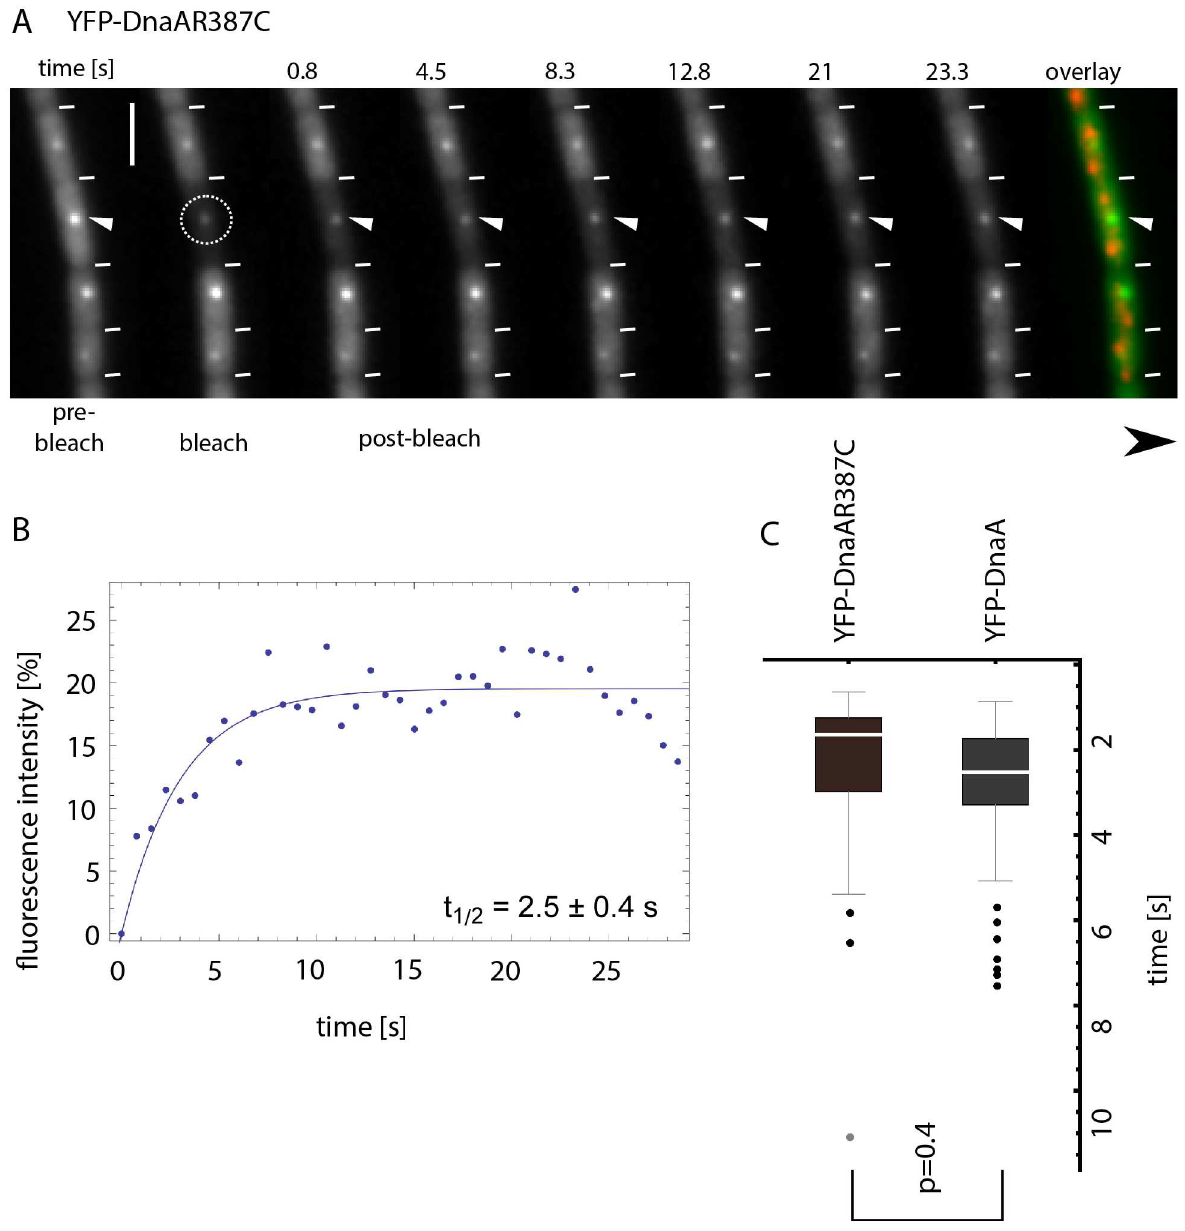
Fig 4. FRAP measurements of YFP-DnaAR387C. A) FRAP sequenceshowingthe recovery of YFP-DnaAR387Cfluorescence signal after bleaching. White triangle, area of interest; white dashedcircle, bleached area. White lines, cell borders; scale bar, 2 μ m. B) Fluorescence intensity plotted over time. Blue line, fit. Recovery half-time is 2.5 ± 0.4 s (n = 33). C) Box-plot showingcalculatedrecovery half-times for YFP-DnaA (ME15) and YFP-DnaAR387C (ME21). Black dots are considered outliers and grey dots extreme values (lie outsideof 1.5 ITR or 3 ITR, respectively). No significantdifference betweenboth half-times could be detected (p = 0.4, students